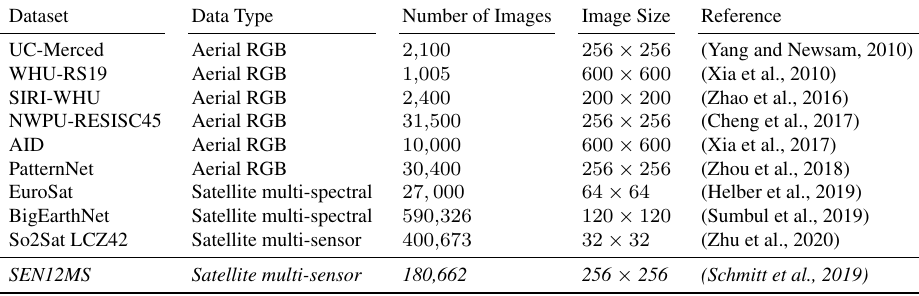
Table 1: Non-exhaustive list of datasets for remote sensing image